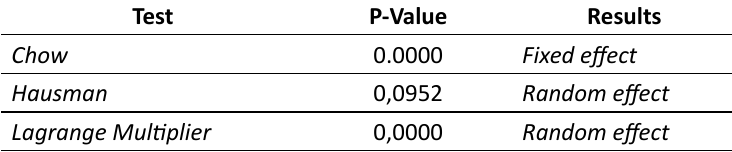
Table 3: Summary of Panel Model Test Results